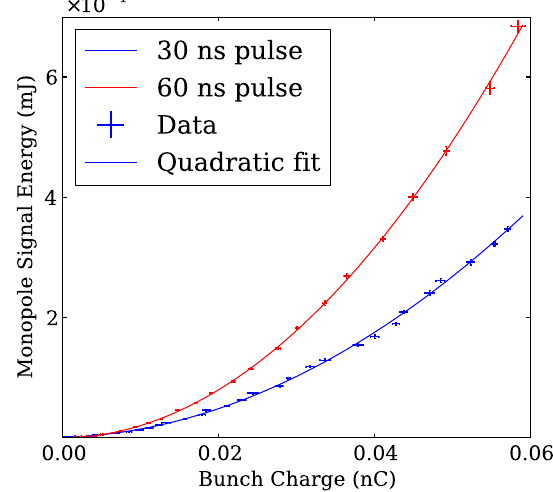
FIG. 11. Total signal energy from the reference cavity for different bunch charges and pulse lengths of 30 and 60 ns.